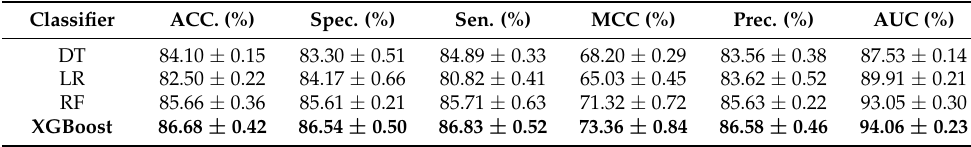
Table 3. Comparison of SMMDA with different classifier